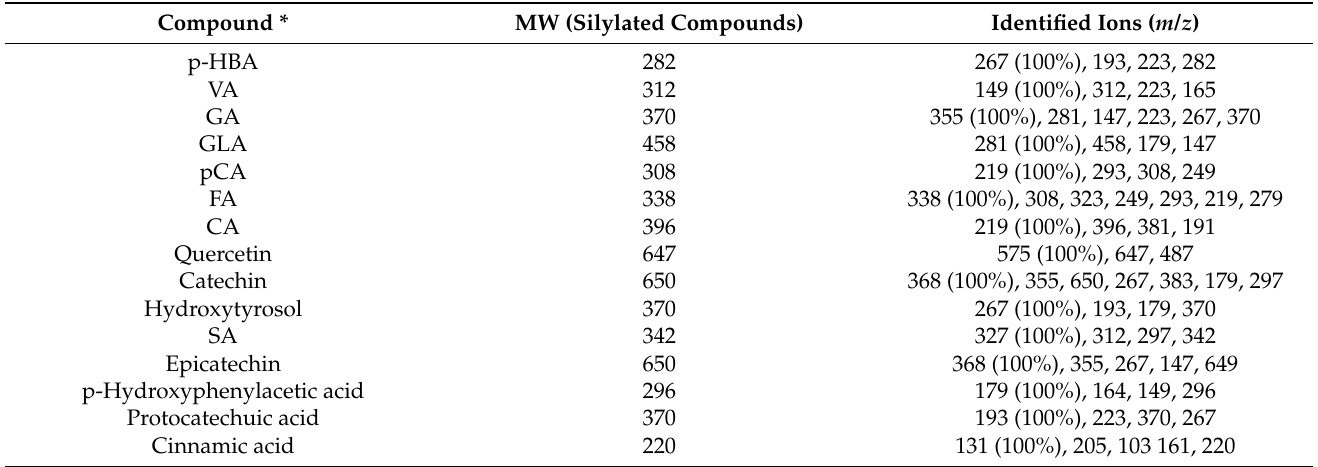
Table 4. Molecular weights (MWs) and identified ions of compounds detected with GC–MS.